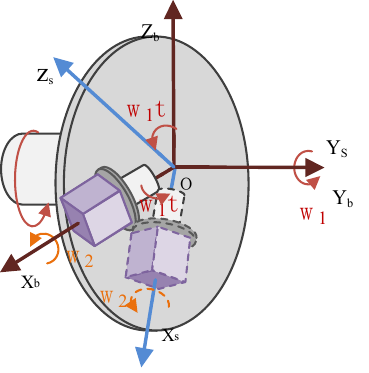
Figure 4. Schematic diagram of biaxial rotating IMU configuration.